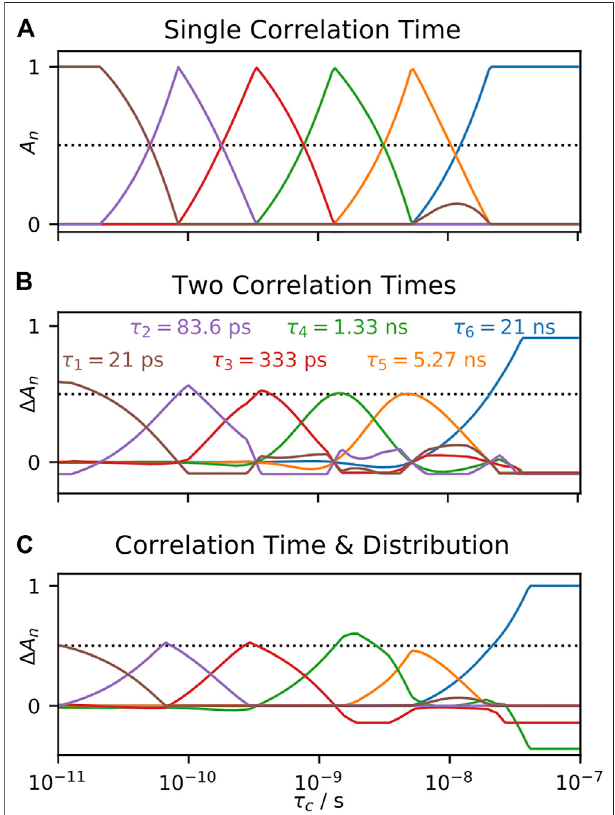
FIGURE 8 | Behavior of the IMPACT approach as a function of correlationtime.Ineachplot,we fi tcalculatedrelaxationrateconstants,and fi t the amplitudes in Eq.25 accordingtotheIMPACT procedure,usingthe setof experiments from Khan et al. (2015). In (A) , the input total correlation function consists of a single decaying exponential term (with amplitude 1), where the amplitudes are plotted as the correlation time is varied. In (B) , the total correlation function uses two correlation times (equal amplitudes), with one fi xed at 1 ns, and the second swept ( x -axis). On the y -axis, we plot contributions to the A k from the correlation time being varied. In (C) , the same information is plotted, but the total correlation function includes a log- Gaussian distribution ( μ (cid:2) 630 ps, σ (cid:2) 1 order of magnitude), and a single, variable correlation